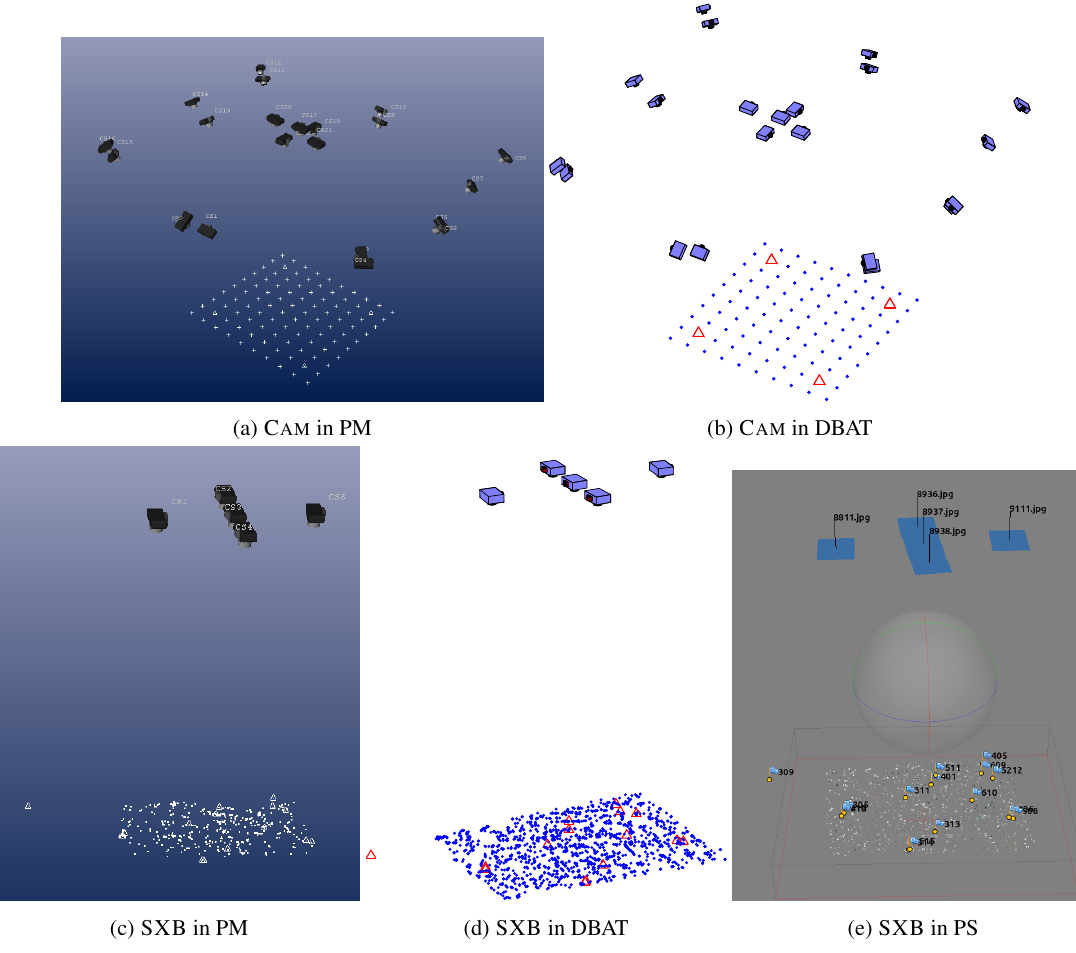
Figure 4. Reconstructed camera